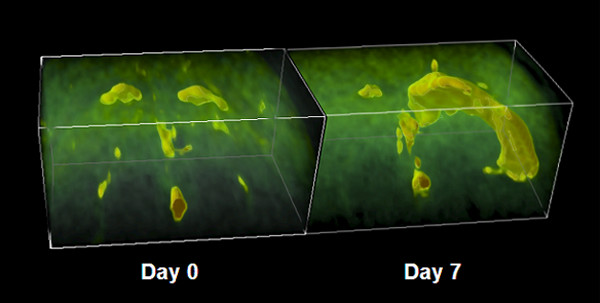
A MRI based 3D image throughout the rat ventricular system. The ventricles are viewed from caudal side, i.e. the targeted right lateral ventricle is on the right. Great enlargement of the AS-ODN receiving right lateral ventricle is seen on day 7.